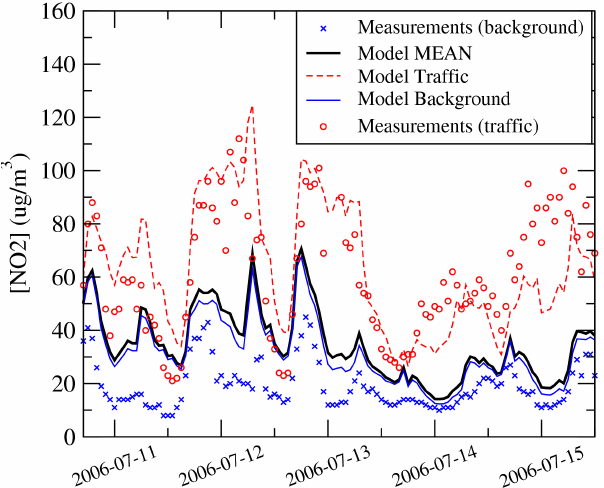
Fig. 20. Surface concentrations of NO 2 time series using the sub- grid scale variability module. The symbols represent AIRPARIF measurements of two stations, one background and one traffic, lo- cated in the same CHIMERE cell in Paris, with a horizontal reso- lution of 3km × 3km. The plain lines represent the corresponding modelled surface concentrations and show the sub-grid scheme is able to reproduce the large variability of NO 2 depending on the sources in an urban environment. After Valari and Menut (2010).